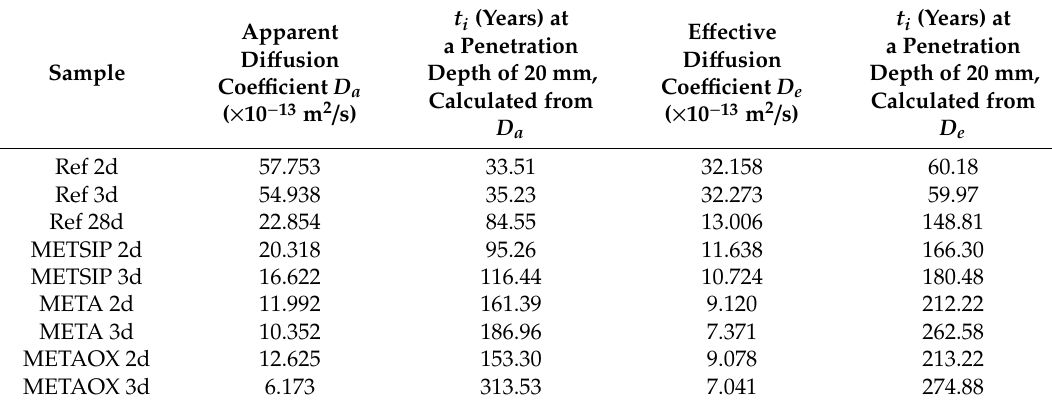
Table 6. Initiation period for the di ff erent